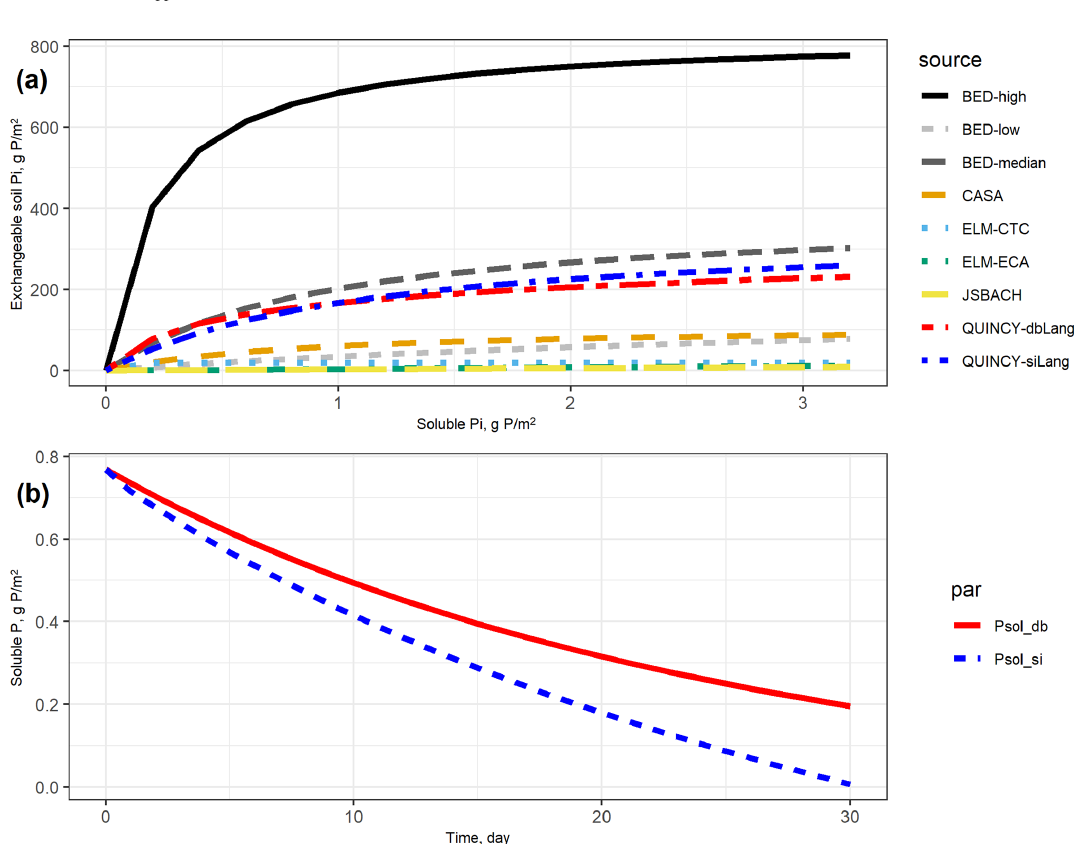
Figure 2. (a) Exchangeable soil inorganic P (P lab and P sorb ) curves based on different terrestrial biosphere model (TBM) parameters and batch experiment data (BED). In TBMs, exchangeable soil Pi is defined as the sum of P lab and P sorb . In BED, soil exchangeable Pi only refers to P lab in Eq. (1) due to a destructive experimental procedure that mobilizes the soil Pi well (Barrow and Shaw, 1979). For the conventional Langmuir model (siLang), P sorb is calculated as 9:8 (global average ratio between P sorb and P lab , reported in Yang et al., 2013) of P lab at all soluble P concentrations; for the double-surface Langmuir model (dbLang), P sorb is calculated following Eq. (3b). (b) Simulated desorption curves for single- and double-surface Langmuir isotherms. The two desorption curves start with the same exchangeable soil Pi (152.2gPm − 2 , P lab + P sorb ) and soluble Pi (0.769gPm − 2 , P sol ) content, and the same amount of P (2.5gPm − 2 ) is removed from soil solution every day. Both Langmuir isotherms are assumed to be in equilibrium at a daily time